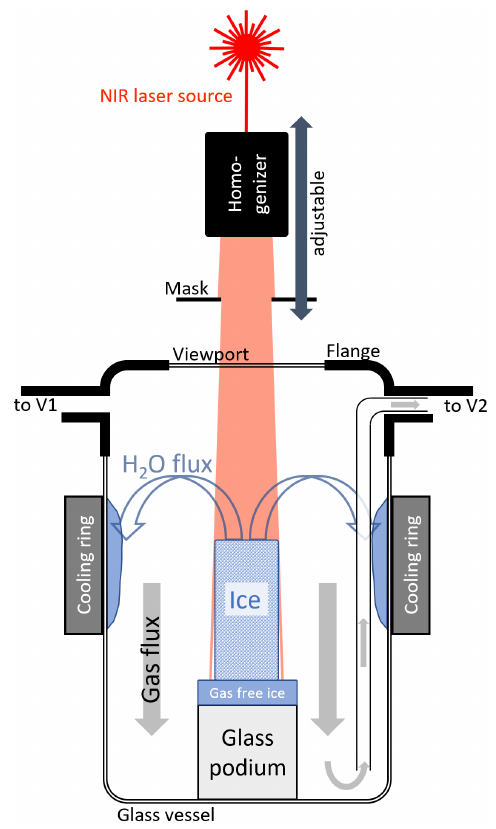
Figure 1. Schematic view of a cross section through the extraction vessel during sublimation. The NIR laser beam induces sublimation at the top ice surface. A small fraction of the beam misses the ice sample and hits the underlying gas-free ice block, which prevents further reflection within the vessel. The resulting water vapor is ef- ficiently removed by freezing to the walls of the vessel, while the released gases are evacuated out of the vessel via a glass tube from the bottom of the